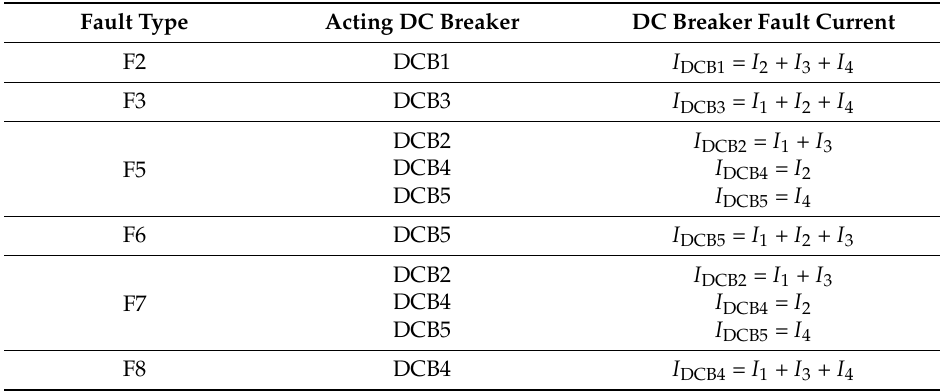
Table 3. DC breaker fault current condition under typical pole ‐ to ‐ pole short circuit fault.